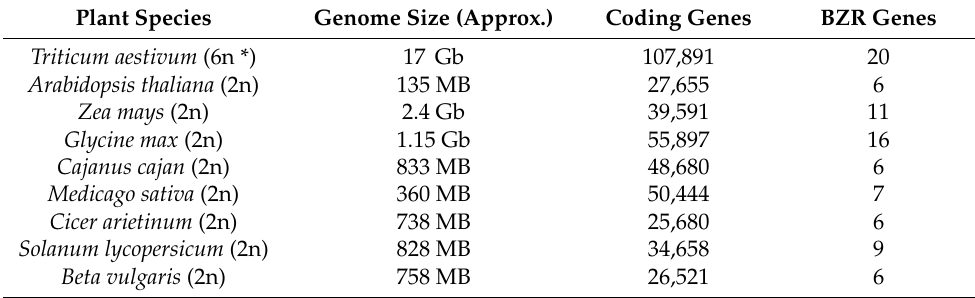
Table 2. The number of BZR proteins in different plant species.